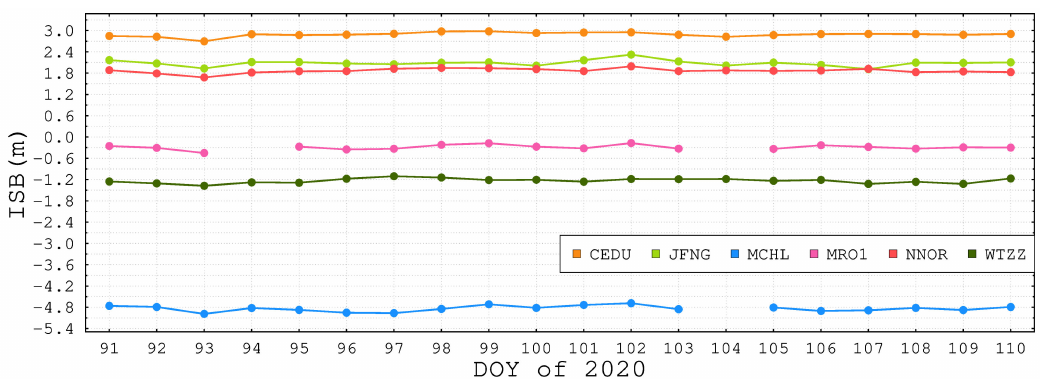
Figure 16. The ISB series of the six stations with GBM precise products from DOY 091 to 110, 2020. Table 3. The mean ISB of six stations with GBM precise products from DOY 091 to 110, 2020, unit—m. CEDU